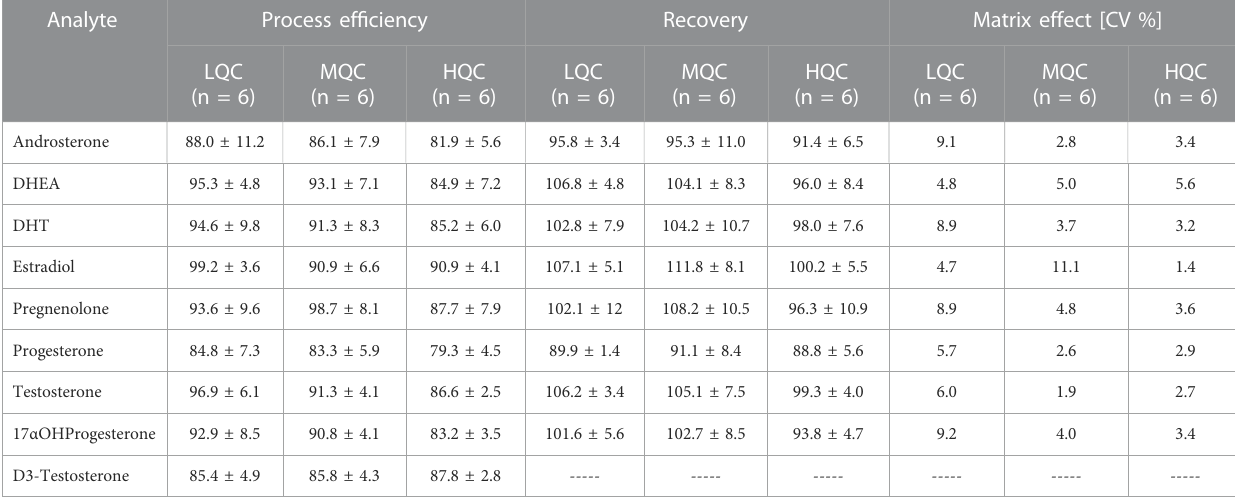
TABLE 3 Validation of developed TF-SPME method for extraction of steroid hormones from urine samples.